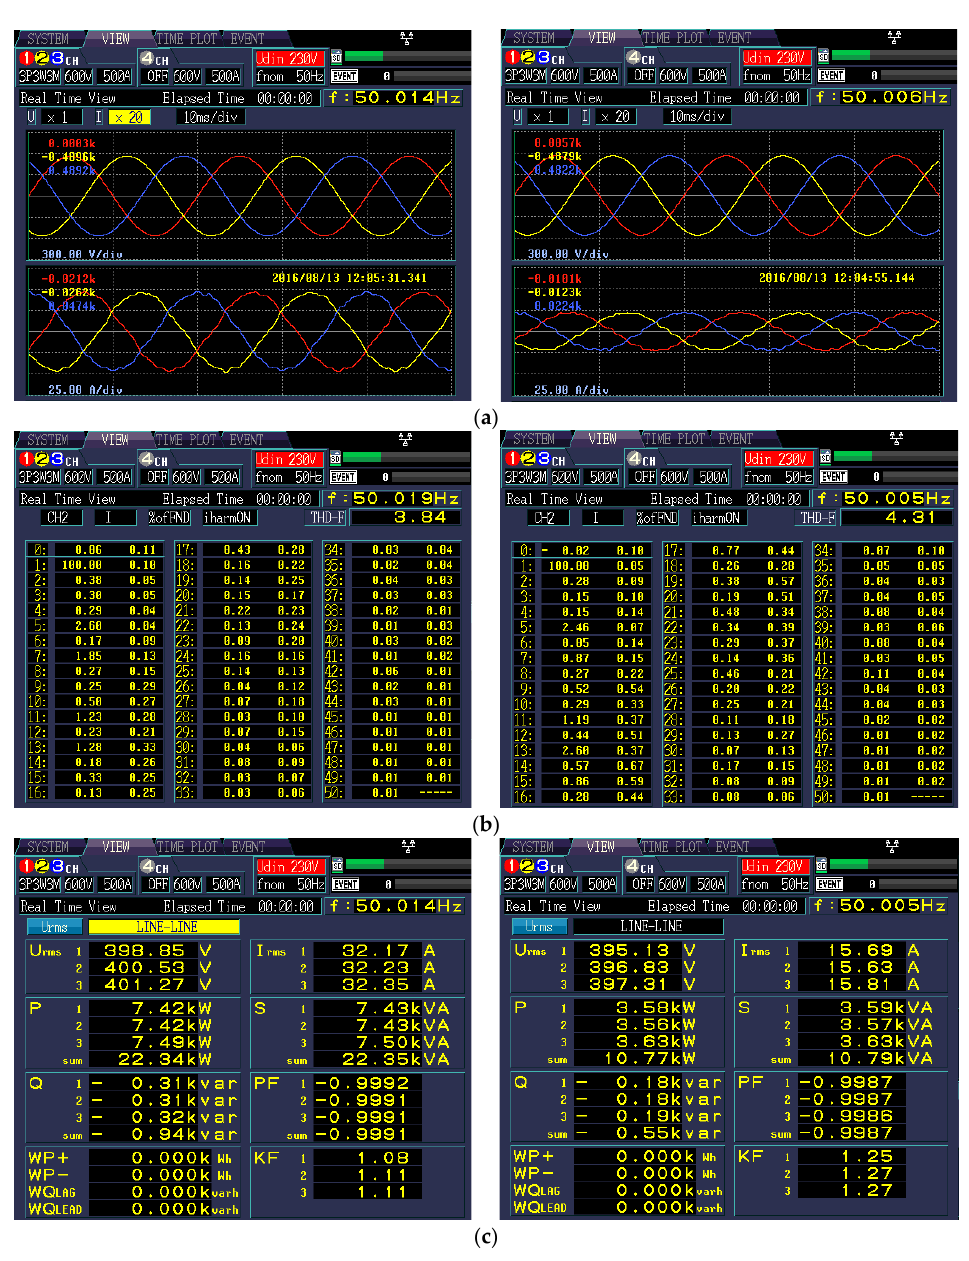
Figure 26. Snapshots of grid-side electrical quantities captured from the experimental set-up in Figure 1b by Hioki Power Analyzer PW3198 at P o = 22 kW (left) and P o = 11 kW (right): ( a ) line-to-line voltage and line current waveforms; ( b ) harmonic content of line current waveforms; and ( c ) output powers.